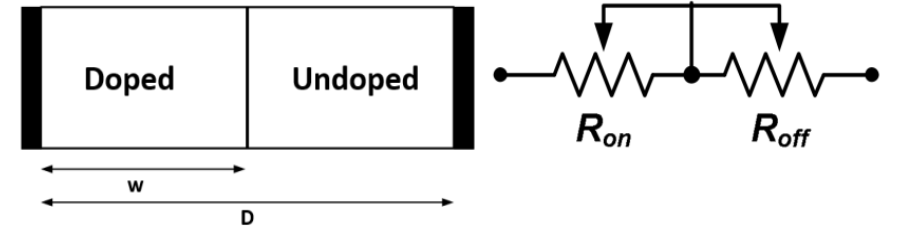
Figure 1. Physical structure and equivalent circuit of memristor [18].